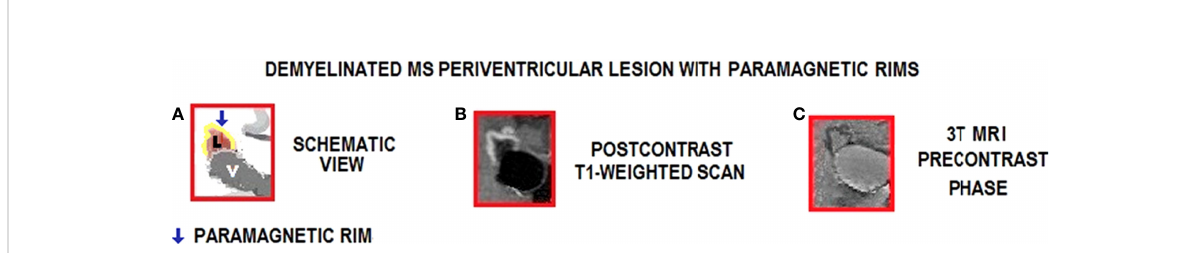
FIGURE 4 In fl ammation in MS periventricular lesions with paramagnetic rims on 3T MRI. Lesion edge shows paramagnetic substances related to in fl ammation. (A) Schematic view of the lesion (pink color) in the periventricular area; (B) Active chronic lesion with peripheral gadolinium leak (centripetal pattern) and paramagnetic border (clear zone); (C) Active chronic lesion with paramagnetic border (delimited by dark gray border), observed without contrast. Images (B, C) show periventricular RRMS lesions with paramagnetic edges (postcontrast and precontrast, respectively, in T1 images); L, Lesion; V, Ventricle.